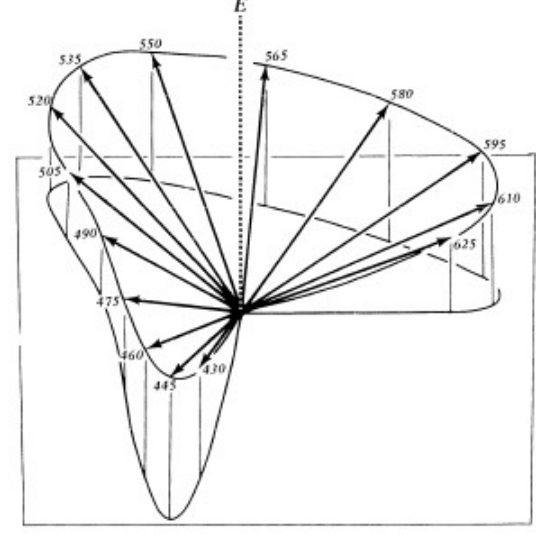
Figure 7: Cohen’s fundamental colour space (from Cohen 37 ) showing the fundamental vectors of monochromatic stimuli in 15 nm passbands from 430 nm to 625 nm. From: American Journal of Psychology , Copyright 1985 by the Board of Trustees of the University of Illinois. Used with permission of the Uni - versity of Illinois